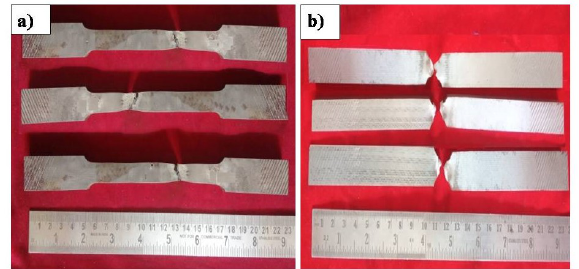
Figure 8: Photographs of Tensile Test Specimen (after testing): a) Unnotched Tensile Specimen, b) Notched Tensile Specimen.